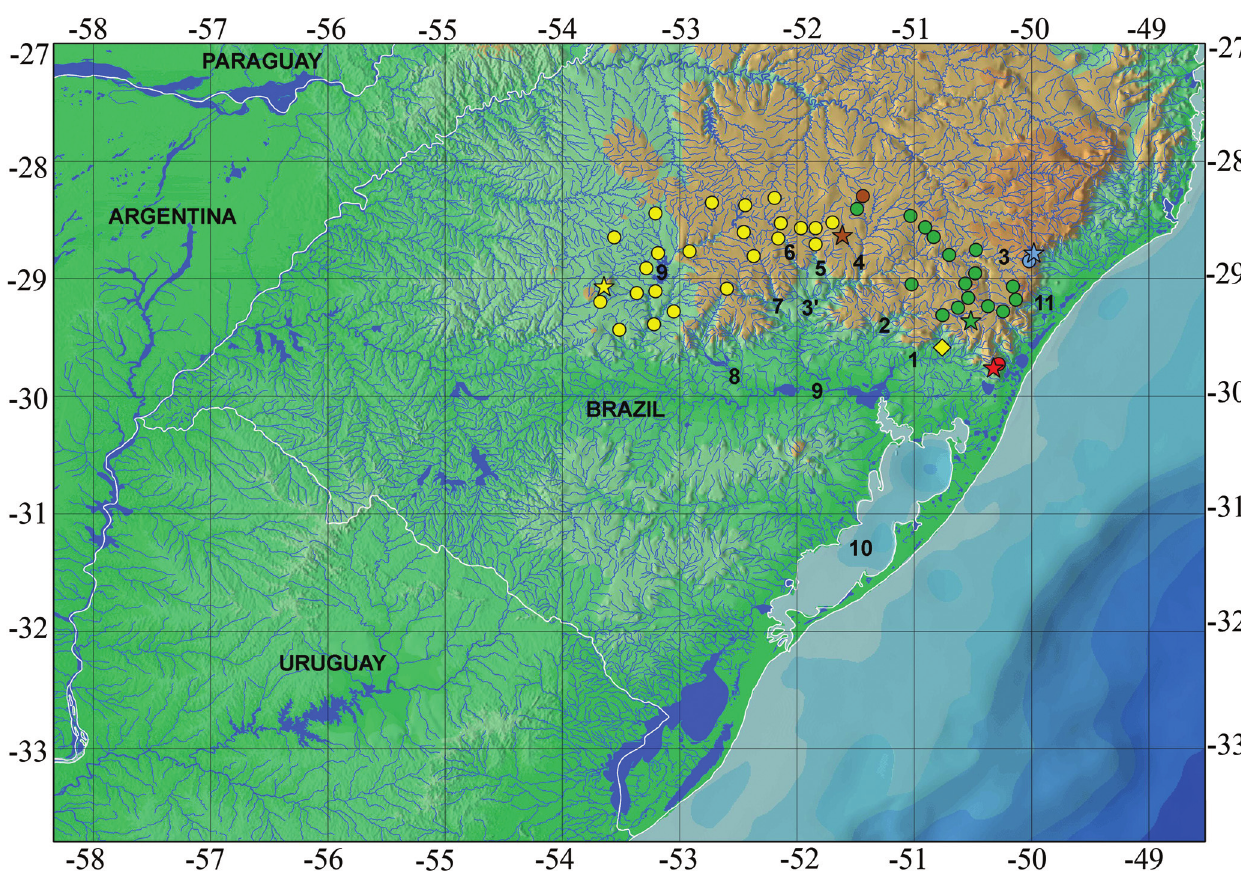
Fig. 8. Geographic distribution of species of Trichomycterus in the laguna dos Patos system. Some symbols represent more than one collection locality. Stars represent type localities. Trichomycterus balios (green symbols), T . brachykechenos (red symbols), T . diatropoporos (brown symbols), T . poikilos (yellow symbols), Trichomycterus cf. poikilos (yellow lozenge) and T . tropeiro (blue symbols), Abbreviations: 1, rio dos Sinos; 2, rio Caí; 3, rio das Antas; 3’, rio Taquari-Antas; 4, rio da Prata; 5, rio Carreiro; 6, rio Guaporé; 7, rio Forqueta; 8, rio Pardo; 9, rio Jacuí; 10, laguna dos Patos; and 11, rio Mampituba